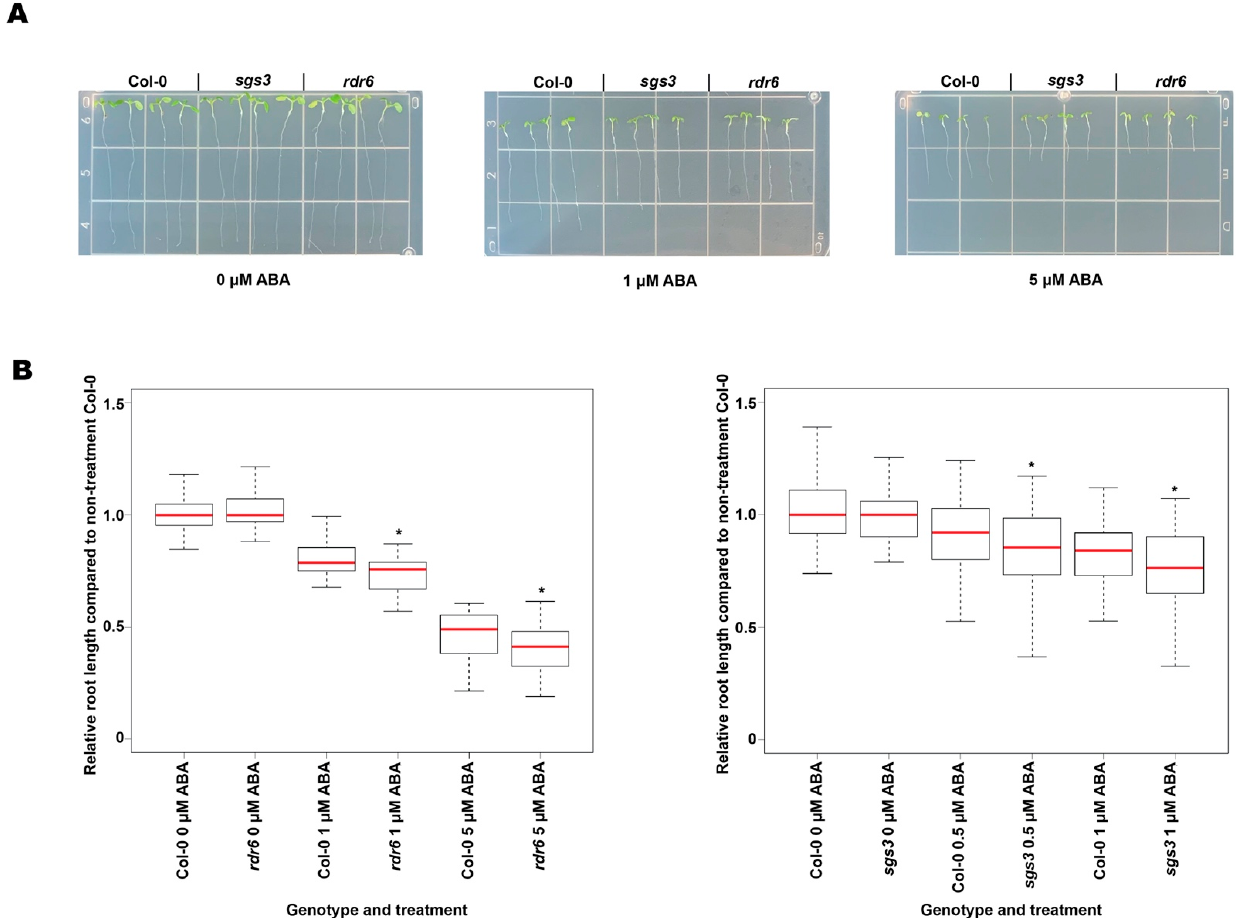
Figure 3. The rdr6 and sgs3 mutant plants are hypersensitive to ABA treatment. ( A ) Representative images of Col-0, sgs3 , and rdr6 seedlings grown under 0, 1, and 5 μ M ABA treatment for five days. From left to right, the genotypes are as indicated. Seedlings were transferred to a new nontreatment plate for photographing. ( B ) ( Left ) Relative root length of Col-0 and rdr6 seedlings under 0, 1, and 5 μ M ABA treatment, x -axis denotes each genotype and ABA concentration used for treatment, y -axis shows the relative root length compared to Col-0 0 μ M ABA treatment. A total of 185 seedlings were measured for these treatments. ( Right ) Relative root length of Col-0 and sgs3 seedlings under 0, 0.5, and 1 μ M ABA treatment. A total of 452 seedlings were measured for this treatment. * denontes p -values < 0.05; Mann-Whitney test.